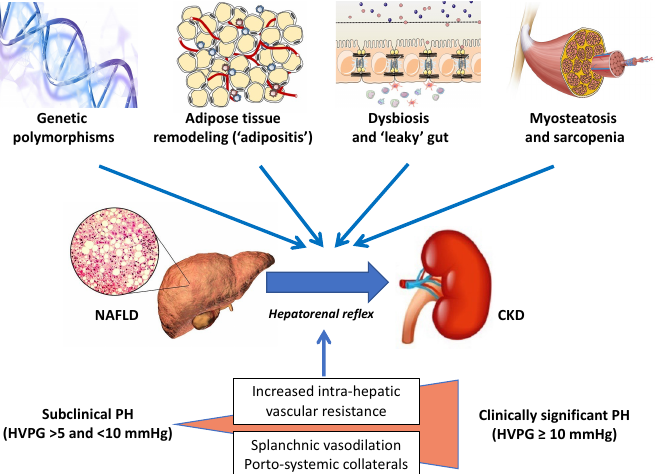
Figure 1. The liver–kidney axis in NAFLD. A schematic illustration of the chief “players” orches- trating the crosstalk between NAFLD and CKD. Specific genetic polymorphisms, including the patatin-like phospholipase domain-containing protein-3 ( PNPLA3) linked to the development of NAFLD, have been also shown to predict the risk of CKD. The risk of kidney damage associated with these genetic polymorphisms is further amplified by environmental factors (e.g., obesity). By far the most prevalent of the modifiable lifestyle factors is obesity, usually originating from excessive caloric intake and reduced physical activity, which is associated with adipose tissue expansion and remodeling. These changes in the adipose tissue result in local and systemic low-grade inflammation that may promote hepatic de novo lipogenesis and steatosis by providing substrates (high levels of LCFAs) and by altering the adipokine milieu (e.g., decreased plasma adiponectin levels). Hepatic steatosis leads to hepatic insulin resistance (facilitated by diacylglycerols and ceramides), NASH, Kupffer cell activation, and the release of multiple proinflammatory cytokines and hepatokines. Myosteatosis is a metabolic dysfunction of skeletal muscles, which may contribute to peripheral insulin resistance and progress to sarcopenia, thereby promoting proteolysis and muscle breakdown. Intestinal dysbiosis is another important link between unhealthy dietary habits and physical inactivity, possibly through the increased production of a variety of microbial metabolites (e.g., SCFAs and lipopolysaccharide), hepatotoxins (e.g., ethanol), and nephrotoxins (e.g., hippuric acid,